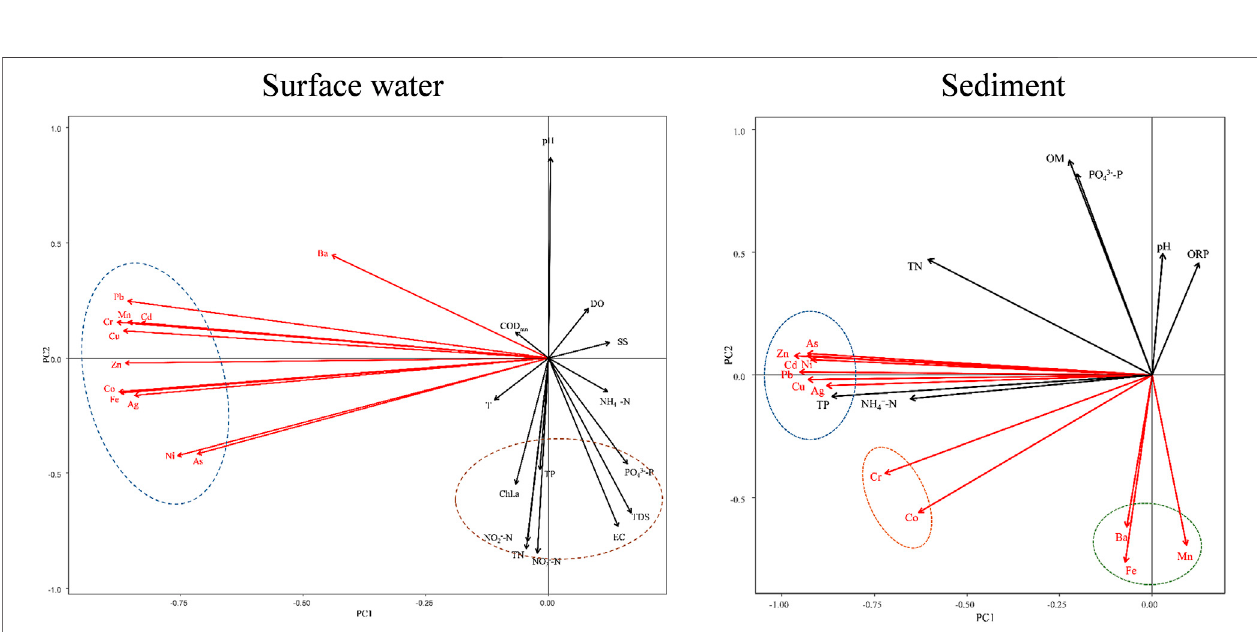
FIGURE 5 | Principal component analysis (PCA) of aquatic environmental parameters and heavy metals.